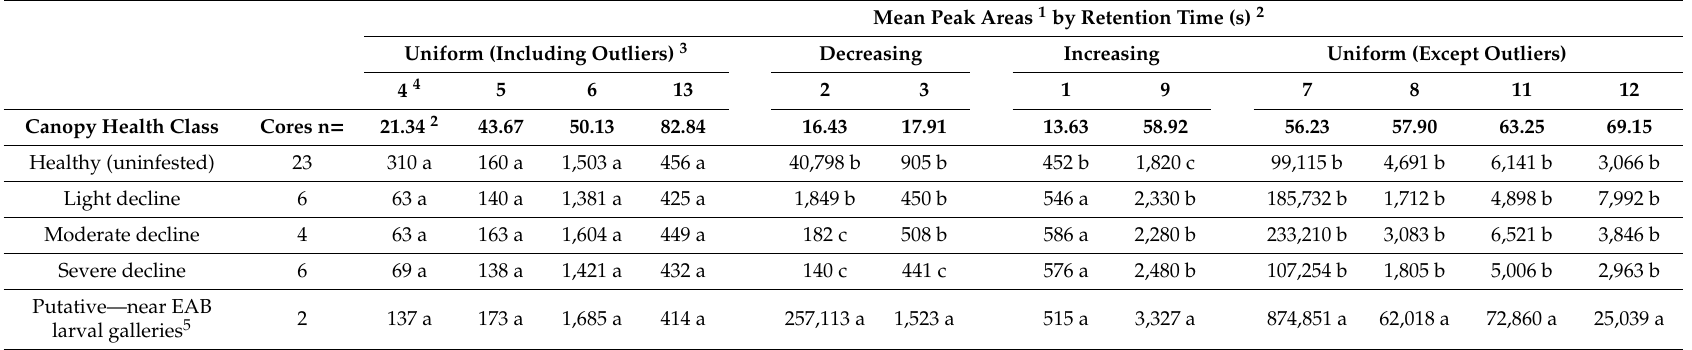
Table 3. Metabolomic e ff ects of EAB-infestation on production of constitutive (putative) host VOC-metabolites within green ash